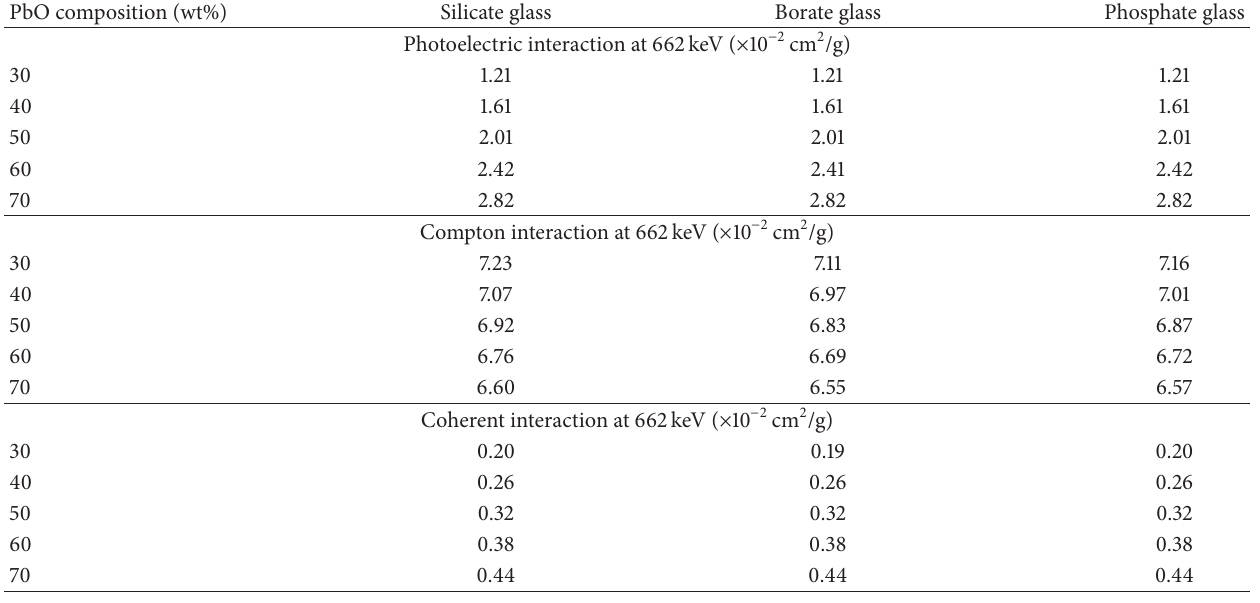
Table 2: Partial interaction of PbO containing silicate, borate, and phosphate glass systems at 662 keV.